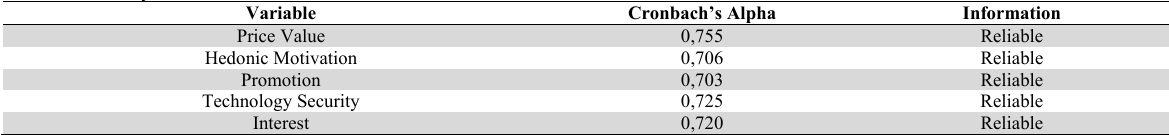
Data Reliability Test Results